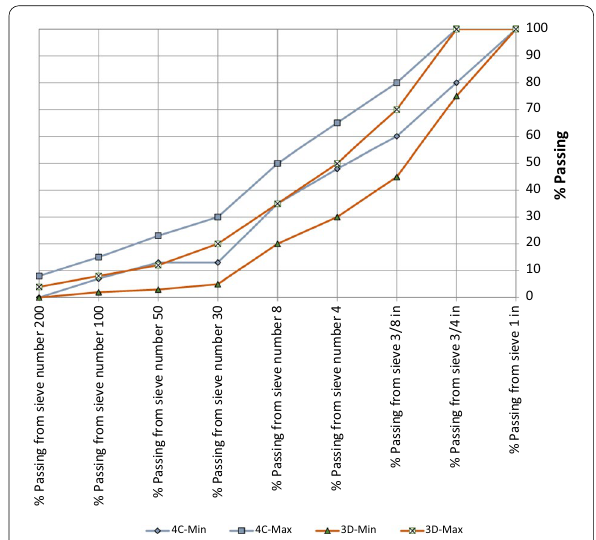
Fig. 2 Aggregate gradation limits for gradations 4C and 3D used in the mixes